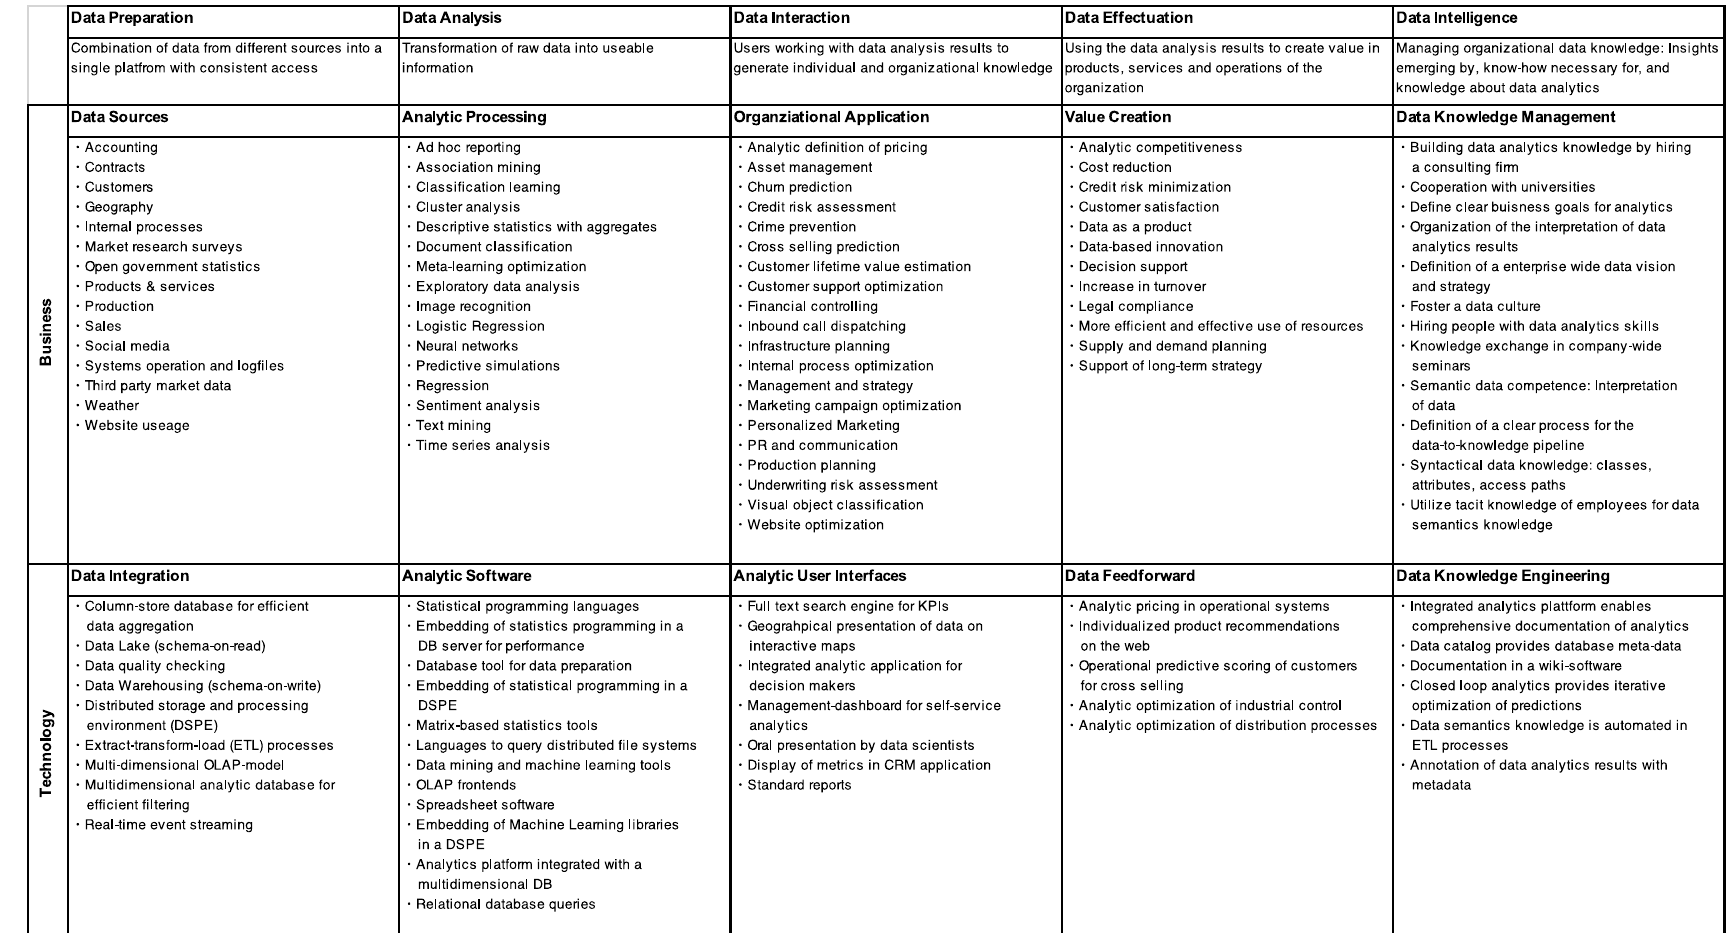
Figure 6. The proposed big data management reference model mapped to observations in three industry cases.